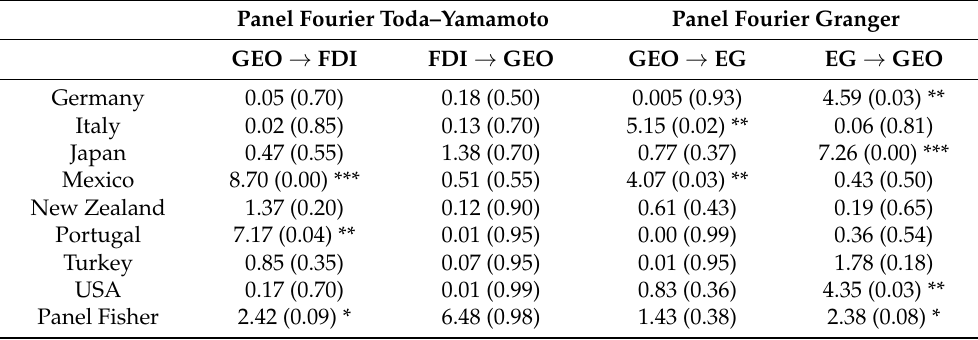
Table 5. Panel Fourier causality and panel Fourier Toda–Yamamoto causality test results. Panel Fourier